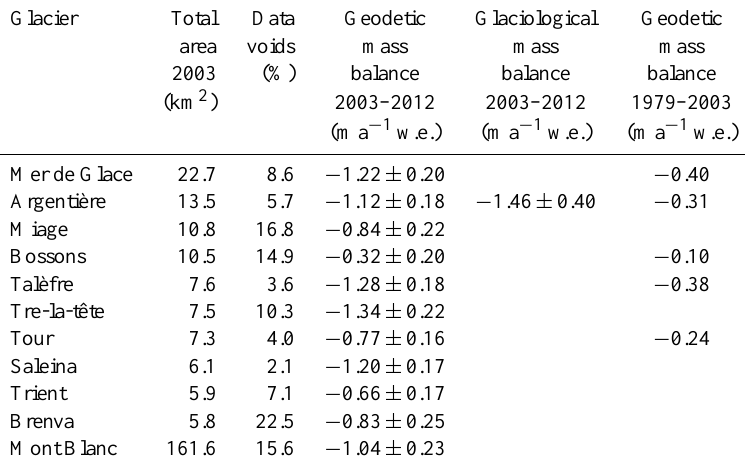
Table 5. Geodetic mass balances for the entire Mont-Blanc area and its 10 largest glaciers, sorted by size. Where available, the 2003–2012 geodetic mass balances calculated in this study are compared to the 1979–2003 geodetic mass balances (Berthier, 2005). The glaciological mass balance is provided for Argentière